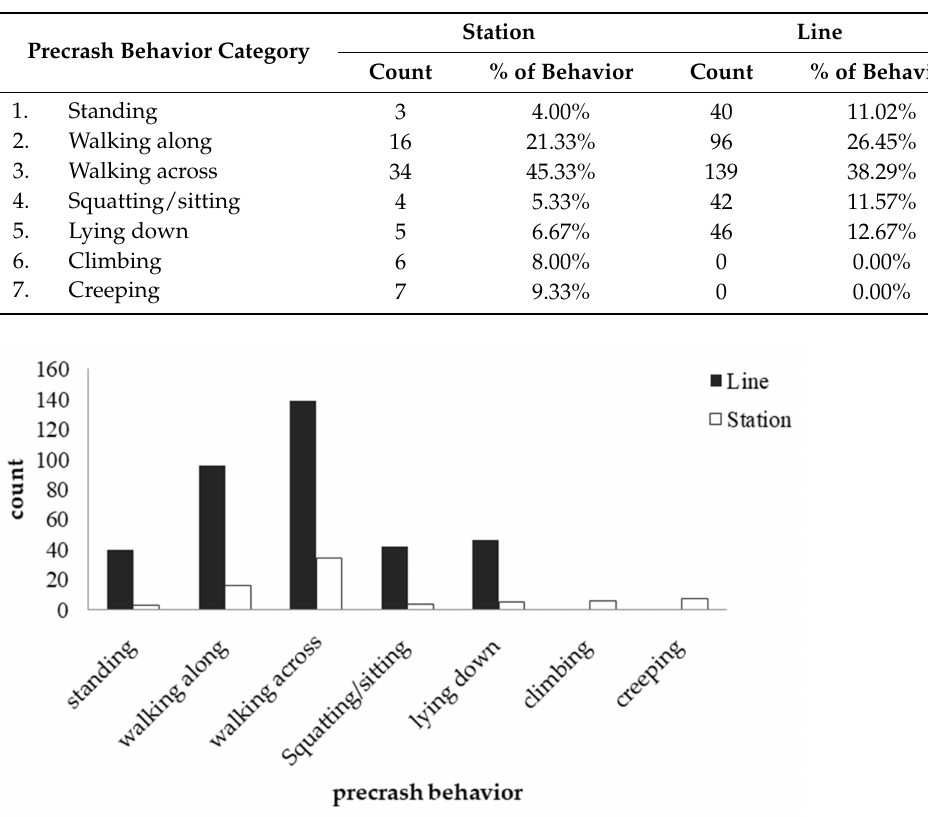
Table 7. Behavior statistics at stations and along lines.